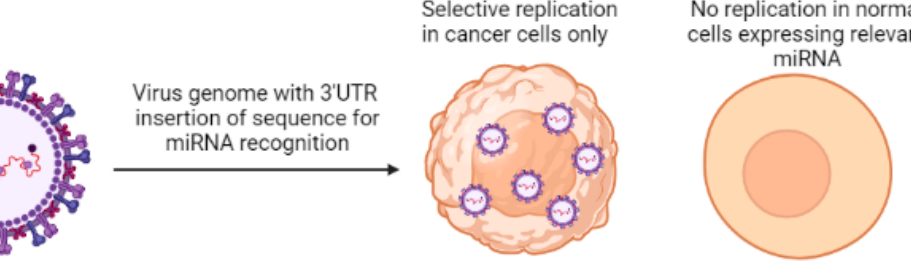
Figure 2. Mechanism of mi-RNA-mediated targeting of oncolytic virus in cancer cells.